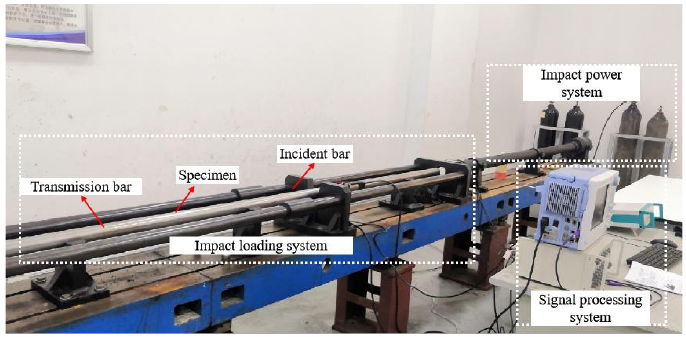
Figure 3. SHPB test system.